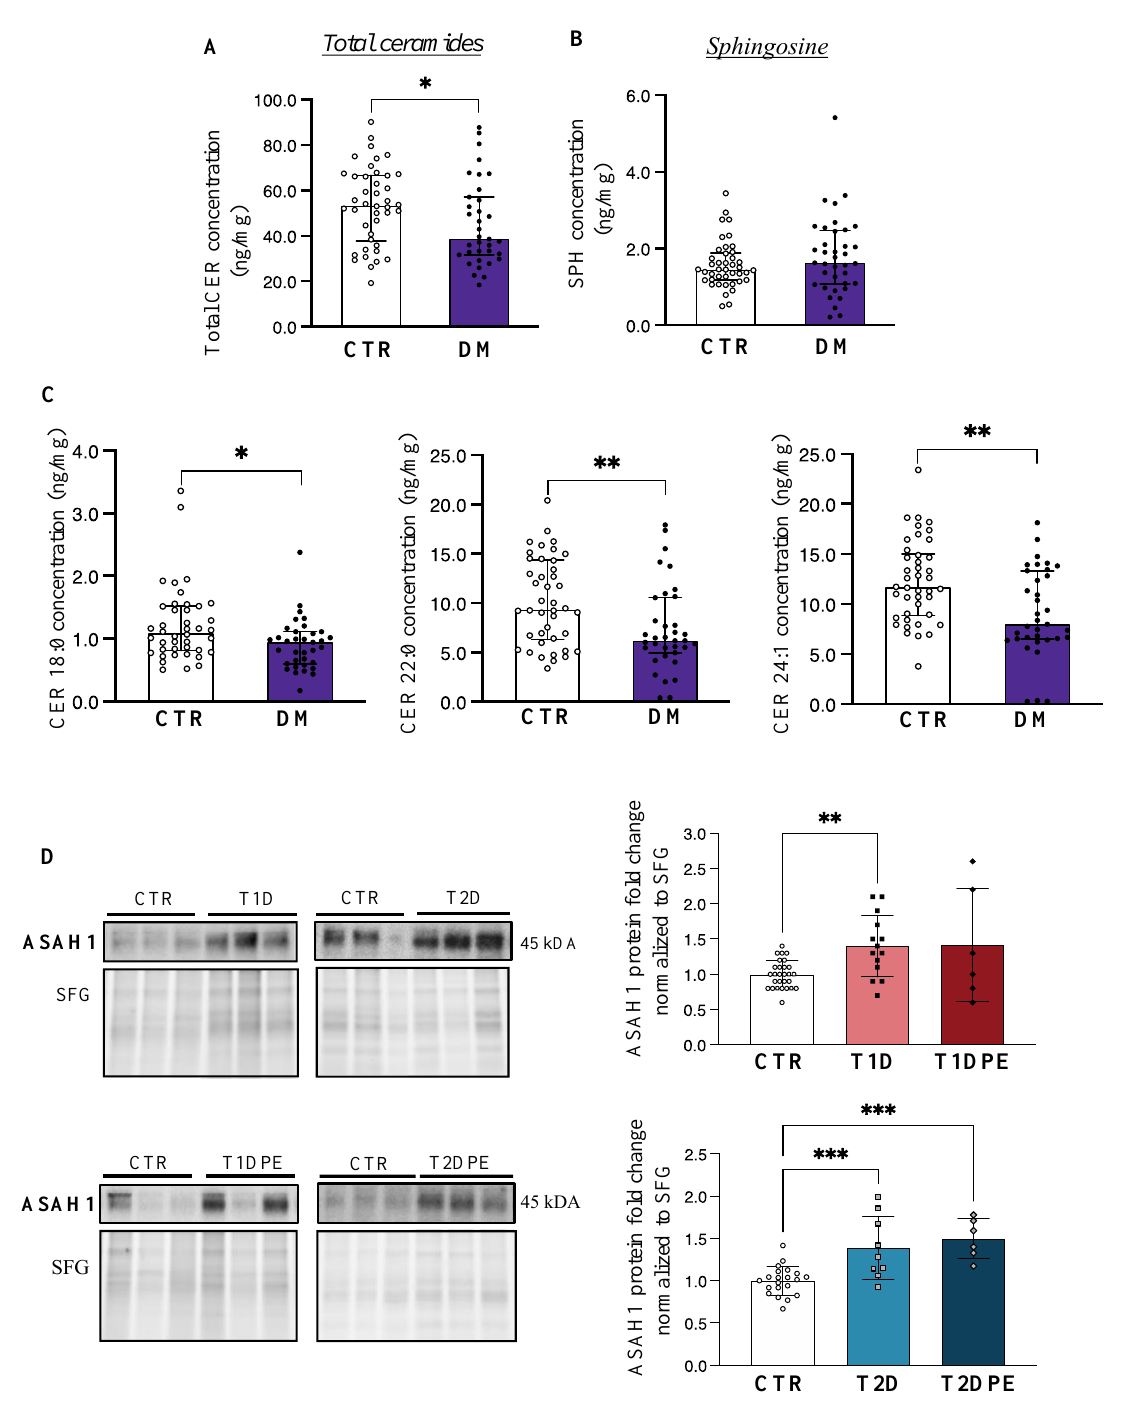
Figure 1. Placental ceramide and sphingosine content and acid ceramidase (ASAH1) levels in pre- gestational diabetes. ( A ) Placental total ceramide (CER) and ( B ) sphingosine (SPH) content in non- diabetic control pregnancies (CTR; n = 42) vs. type 1 and type 2 diabetes (DM; n = 35–37). ( C ) Placental CER 18:0, 22:0, and 24:1 levels CTR vs. DM. Values are median ± IQR. ( D ) Representative Western blots and associated densitometry analysis of placental ASAH1 in CTR ( n = 28), type 1 diabetes (T1D; n = 14), T1D with preeclampsia (T1DPE; n = 6), type 2 diabetes (T2D; n = 9), and T2D with preeclampsia (T2DPE; n = 6). Data are mean ± SD. * p < 0.05, ** p < 0.01, *** p < 0.001. DM: Diabetes Mellitus.